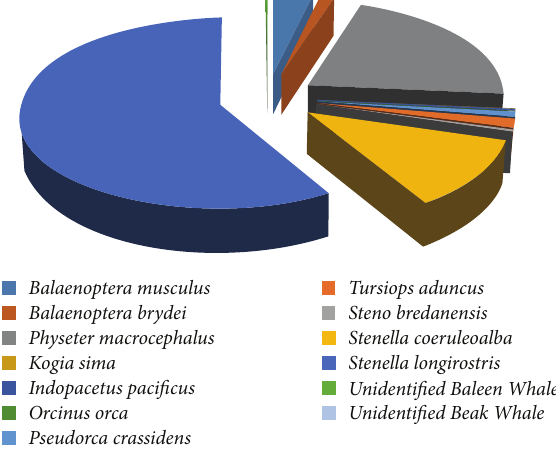
Figure 4: Total no. of individuals